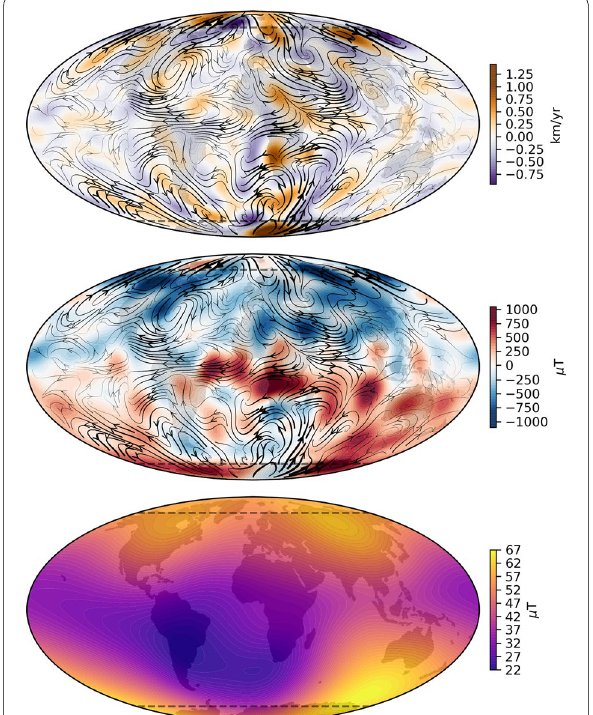
Fig. 13 Maps of the flow just below the CMB (top), radial magnetic field at the CMB (middle) and field intensity at the Earth’s surface (bottom). The horizontal flow is shown with streamlines, while the radial field is displayed by the color scale. The maps are based on the assimilation analysis in 2020 and are given in Mollweide projections